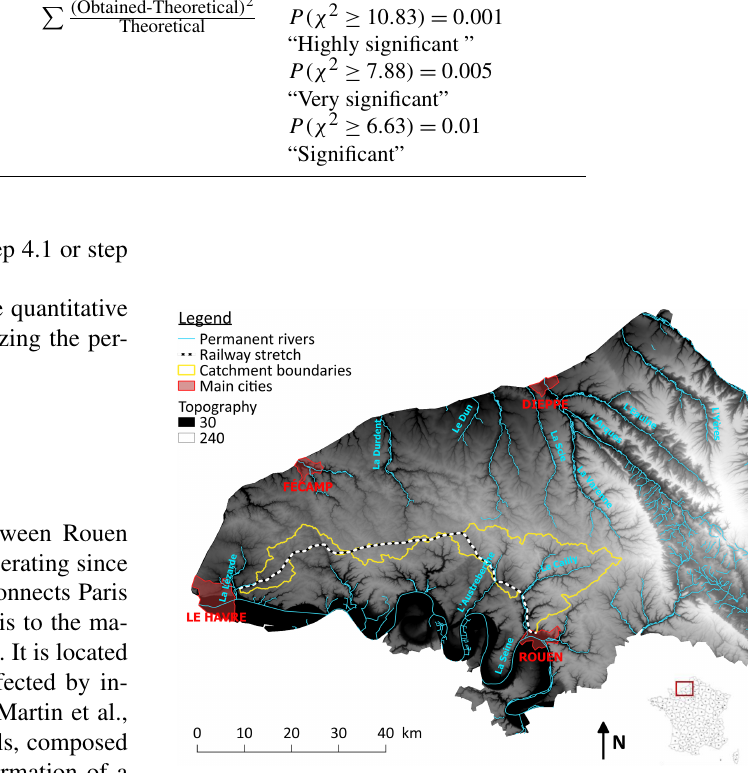
Figure 4. Map of the study area in Normandy (northern France). The yellow contour is the boundary of the catchments intercepted by the Rouen–Le Havre railway (line in black and white). Blue lines are the permanent river courses. One can note the dense network of dry thalweg (darker on the DEM) upstream of rivers that can be activated during a rainfall